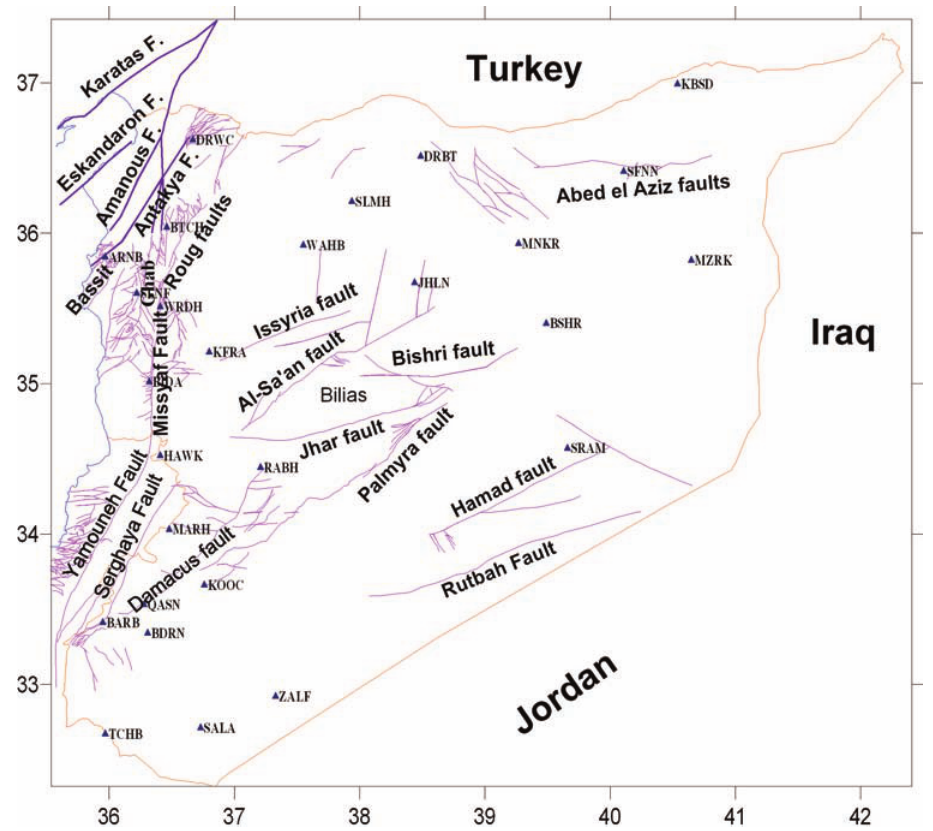
Figure 2. Map of the geographical distribution of the Syrian National Seismological Network ( ▲ ) and the principal faults in this